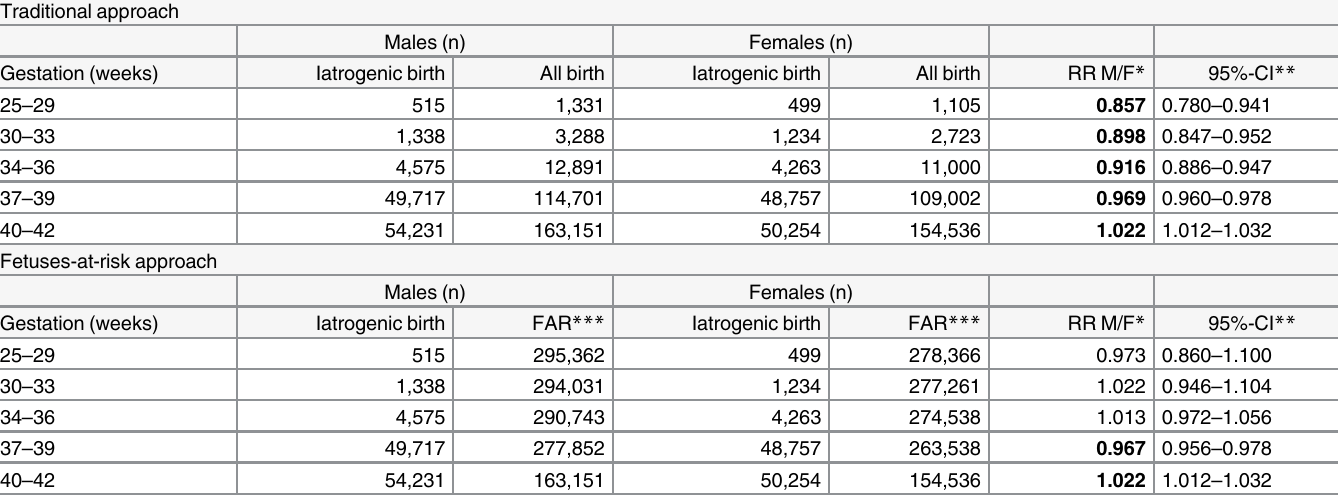
Table 4. Sexual dimorphism for iatrogenic birth by length of gestation in